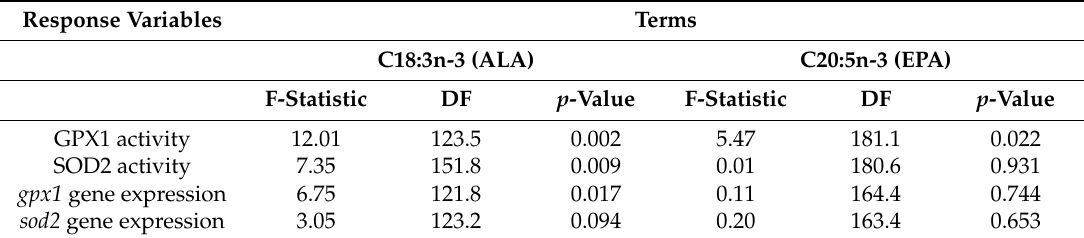
Table 4. Statistical significance ( p -values) for the relationships between muscle n-3 fatty acids and activities or gene expressions of glutathione peroxidase 1 (GPX1) and superoxide dismutase 2 (SOD2) antioxidant